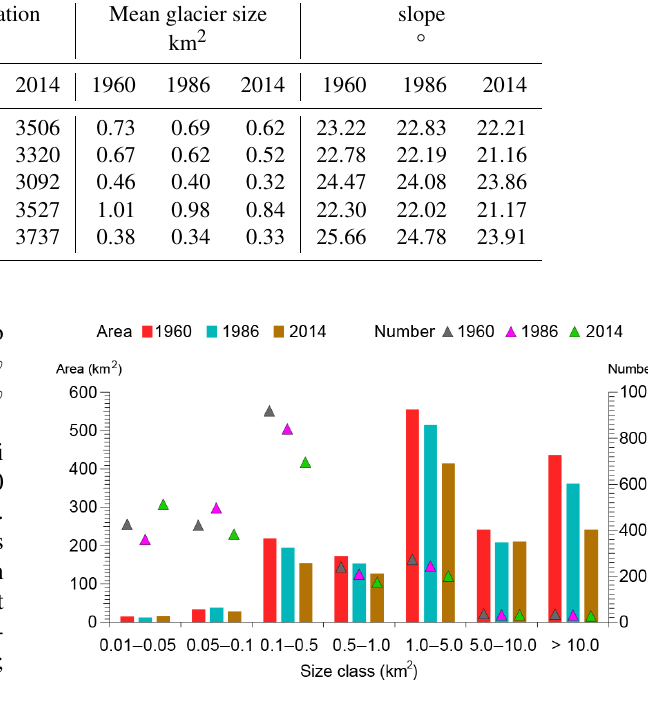
Figure 5. Cumulative glacier area and number values for seven size classes in the Greater Caucasus in 1960, 1986 and